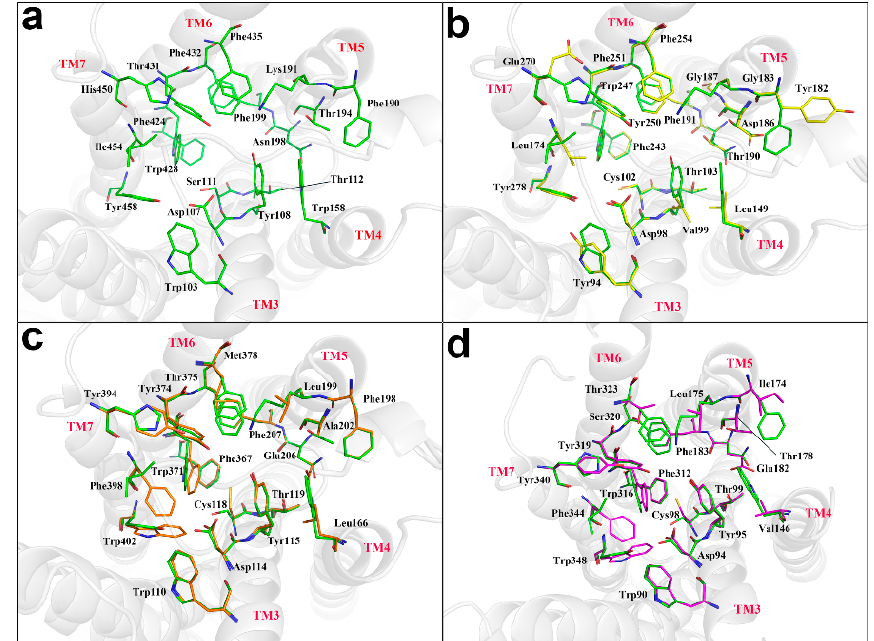
Figure 3. Schematic diagram of the histamine receptor structure binding cavity, with 7 transmembrane domains labeled by the gray cartoon. ( a ) The H1R cavity binding site was shown by a green ball-and-stick model; ( b ) superimposed charts of H1R and H2R, with H1R-green, H2R-yellow; ( c ) superimposed charts of H1R and H3R, with H1R-green and H3R-orange; ( d ) superimposed charts of H1R and H4R, with H1R-green and H4R-magenta.